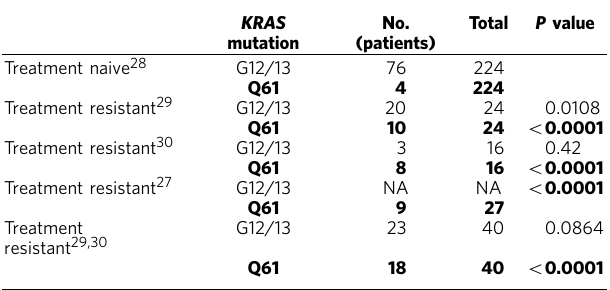
Table 1 | KRAS mutational status prevalence among treatment naive and treatment resistant